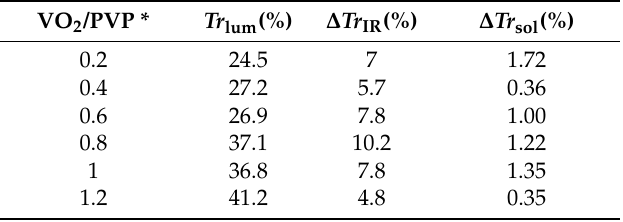
Table 1. Optical characteristics of VO 2 /polymer nanocomposite